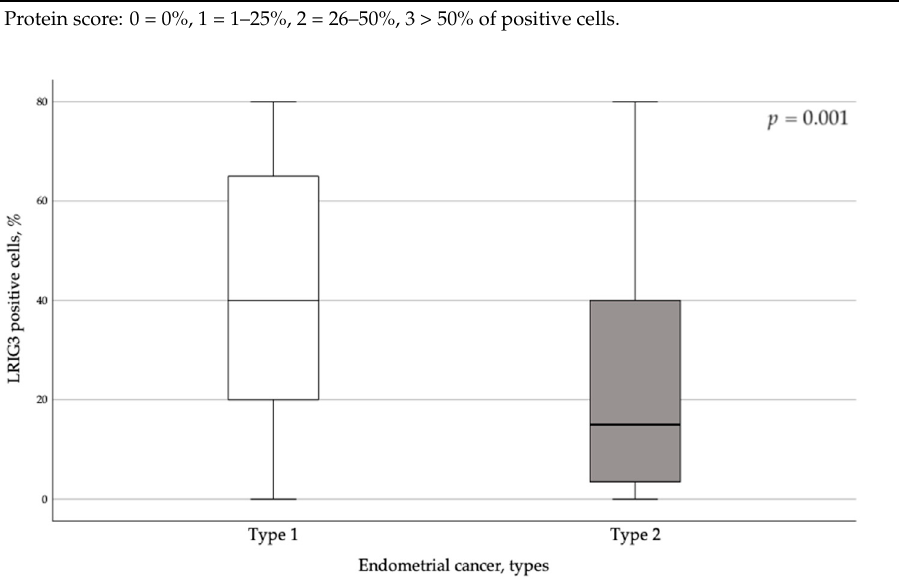
Figure 2. LRIG3 positive cells (%) in different endometrial cancer tumor types. Table 2. Immunohistochemical staining for LRIG1, LRIG2, and LRIG3 ( n = 75).